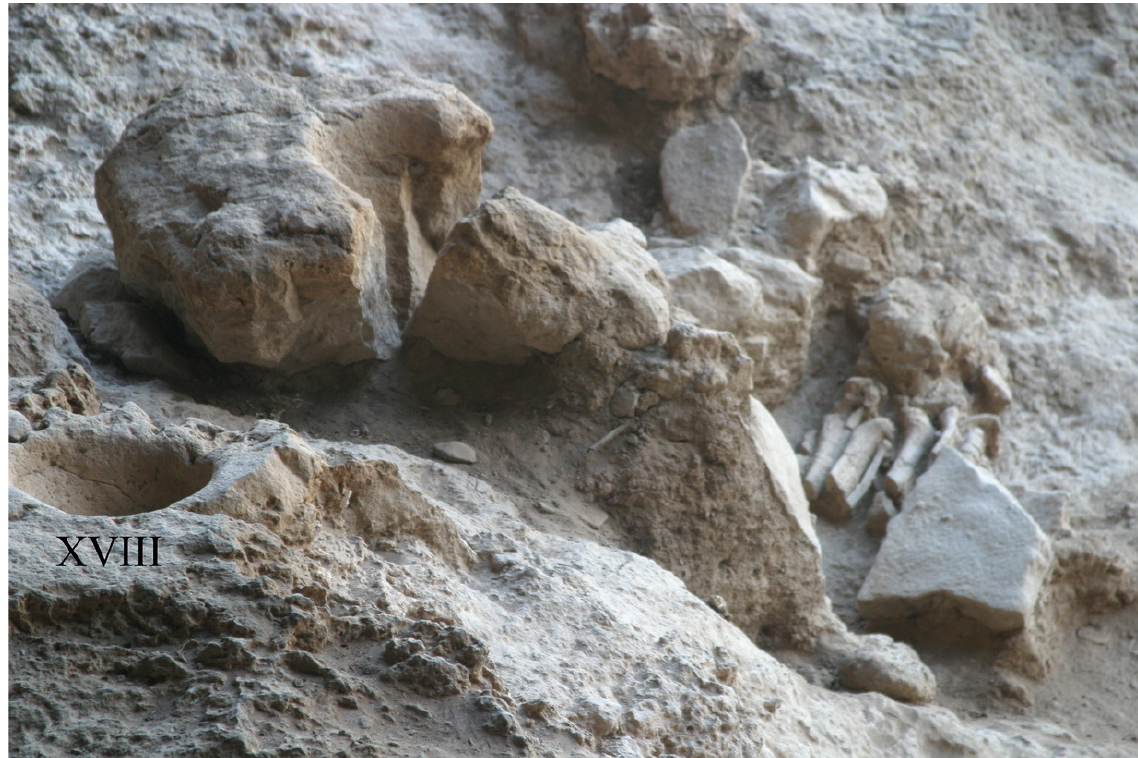
Figure 6. Mortar C-XVIII with the split boulder mortar behind it, and a Natufian skeleton below.